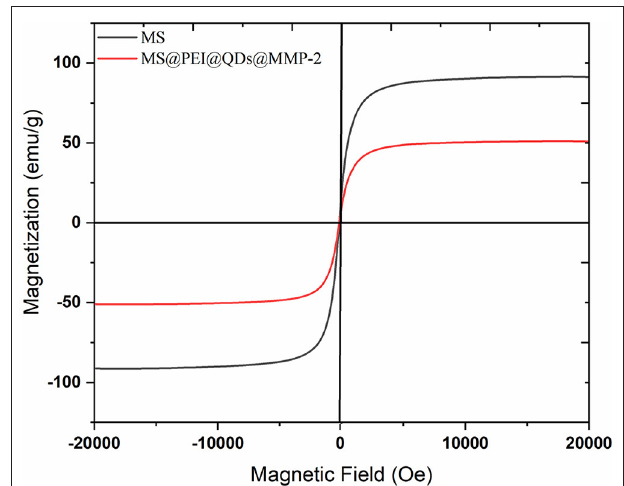
FIGURE 3 | Magnetization curves of blank magnetic microspheres (black line) and MS@PEI@QDs @PEI@MMP-2 (red line).